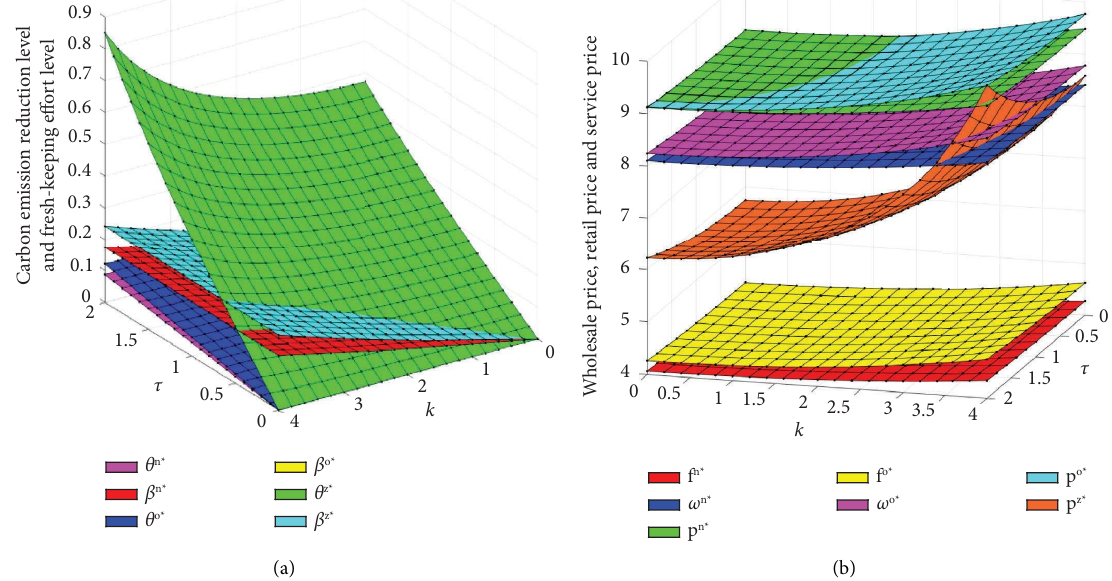
Figure 2: Efects of c and k on supply chain system decisions.